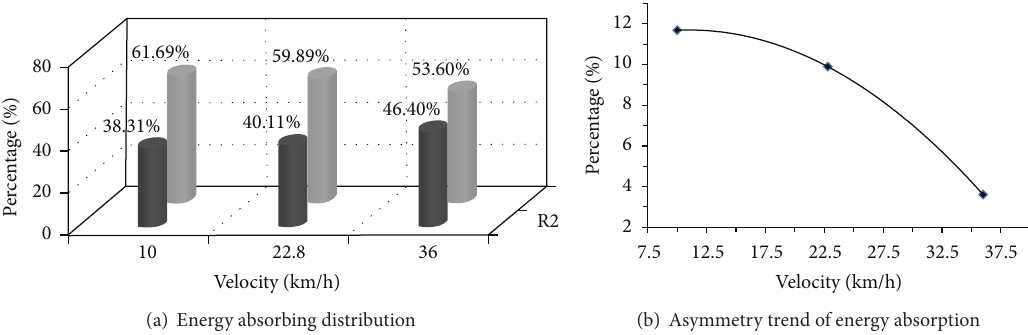
Figure 9: Energy absorption in main energy absorbing